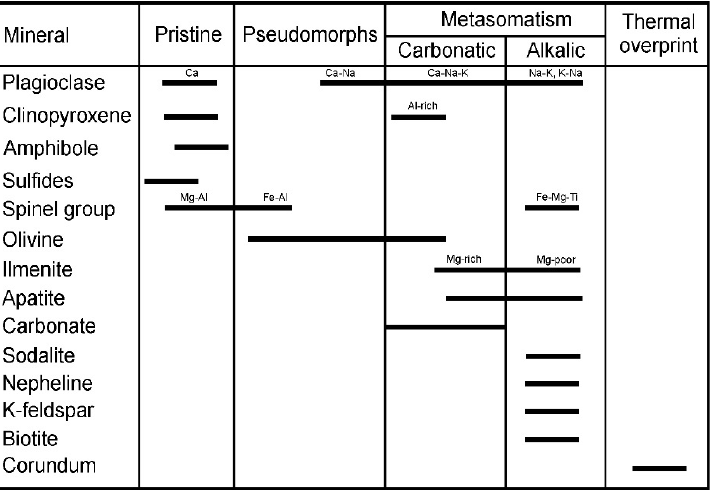
Figure 5. Succession of crystallization and mineral parageneses in calc ‐ silicate xenoliths from Č